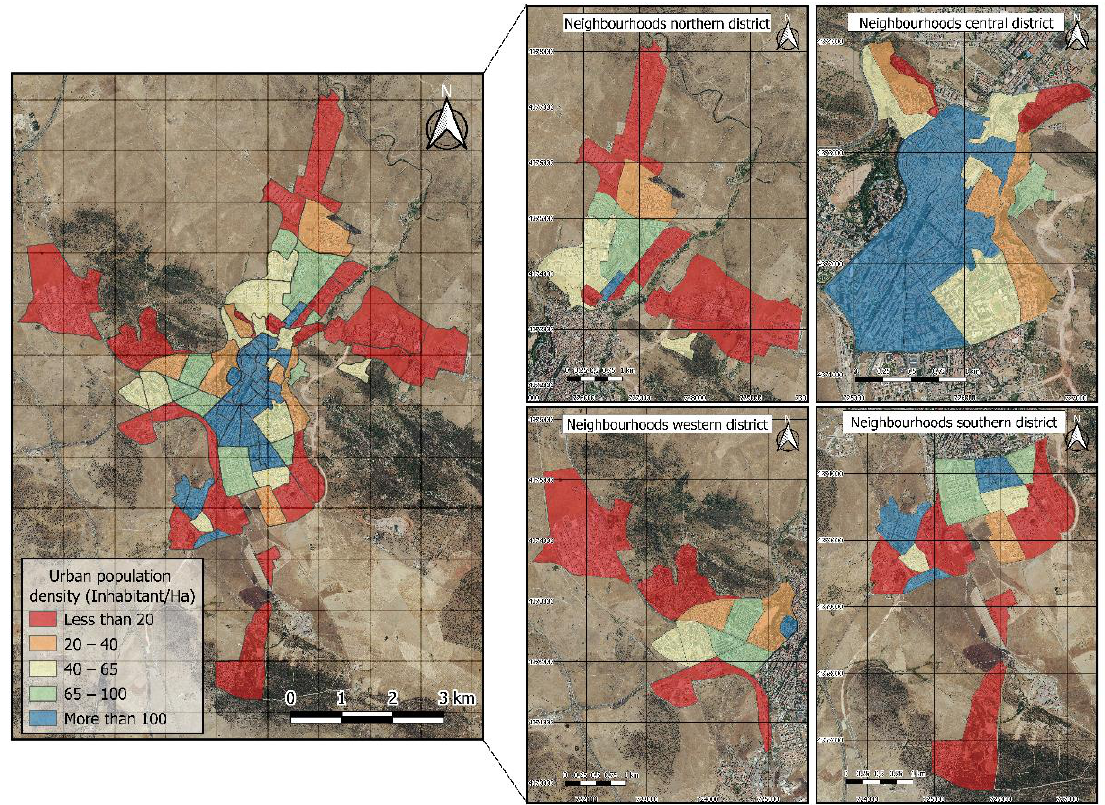
Figure 4. Urban population density.